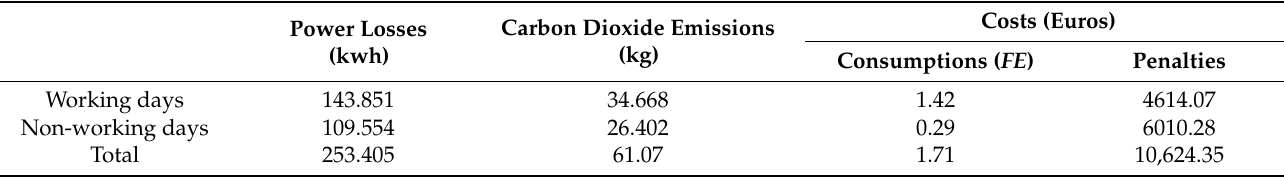
Table 13. Summary of 1000 kVA Ormazabal transformer savings in energy losses, carbon dioxide emissions, and economic